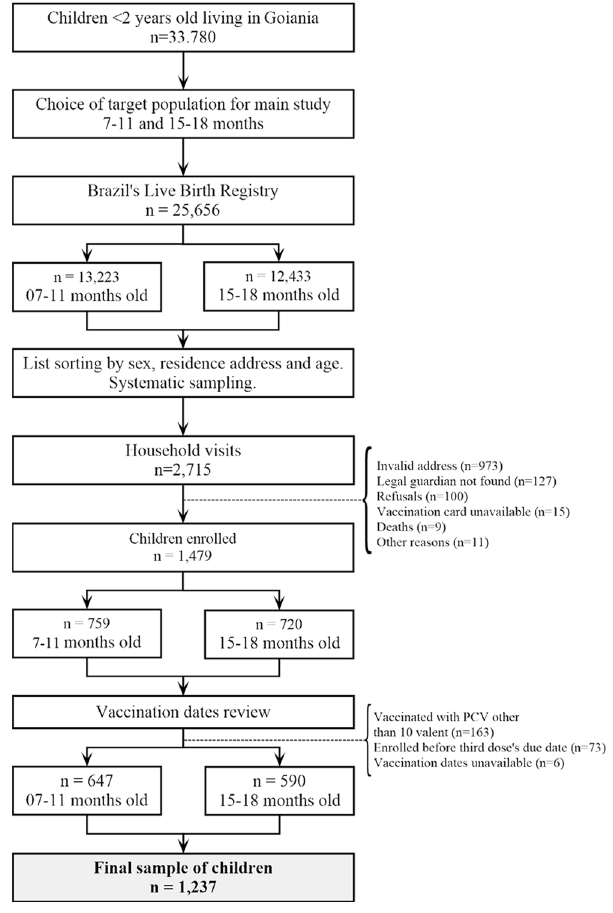
Fig 2. Flowchart of children selection. Goiania, December 2010 to February